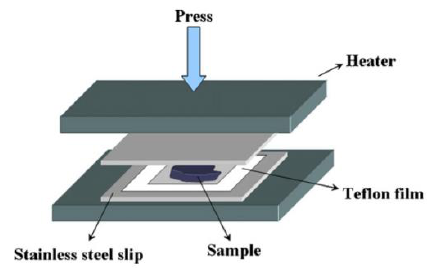
Figure 2. Scheme of the membrane preparation set-up via TIPS, adapted from [9] .